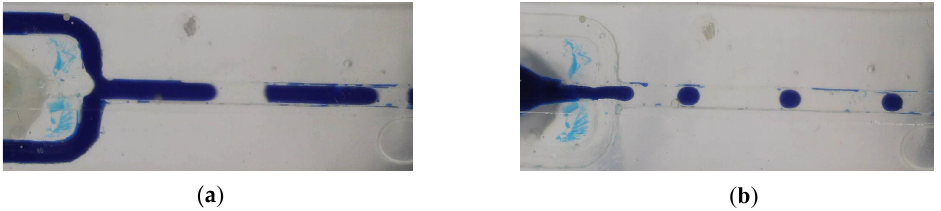
Figure 4. Formation of emulsions in ESCARGOT chip with silicone walls (Fig ure 2c): ( a ) direct; ( b ) inverse.